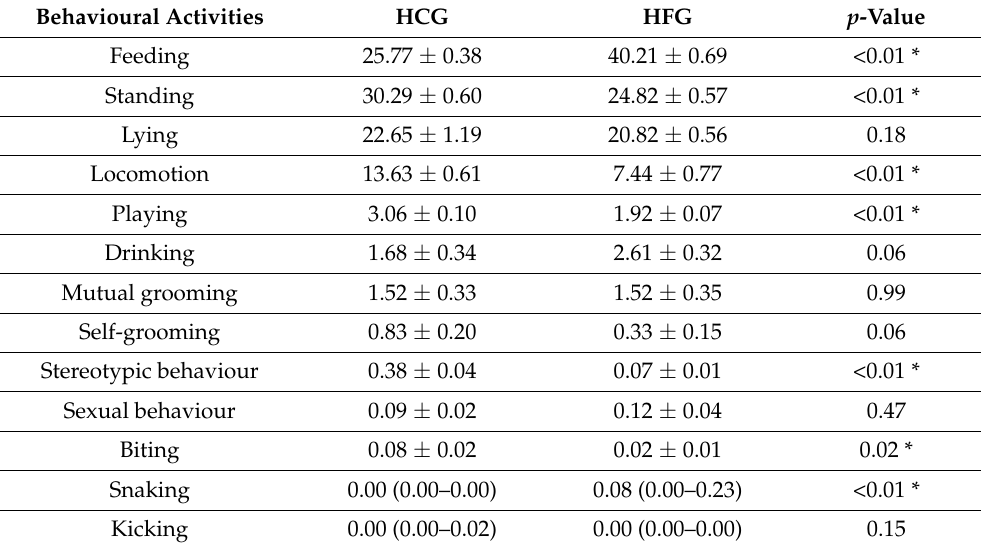
Table 2. Time budget (%/24 h) engaged in different behavioural activities (HCG vs. HFG). All data are expressed as means ± SEM, with the exception of snaking and kicking which are expressed as medians (plus 25th–75th